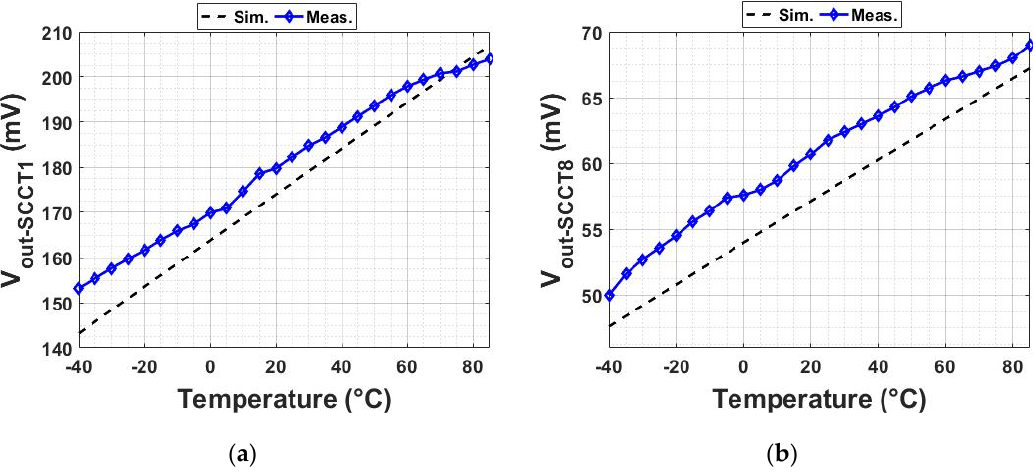
Figure 6. Measured output voltage as a function of temperature for ( a ) SCCT1 and ( b ) SCCT8 using I Bias of 10 µA.